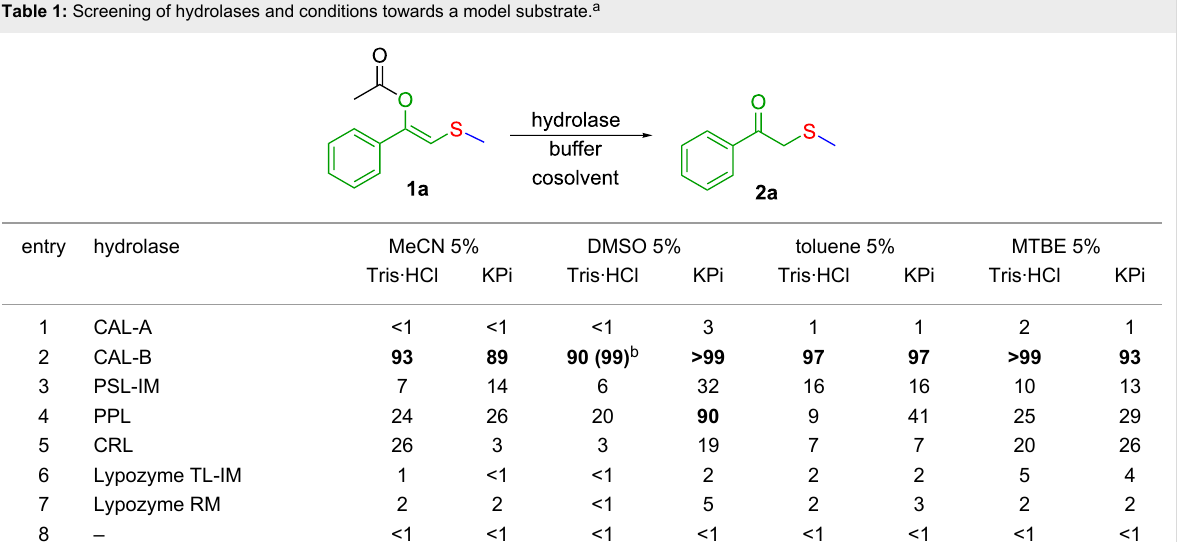
Table 1: Screening of hydrolases and conditions towards a model substrate. a